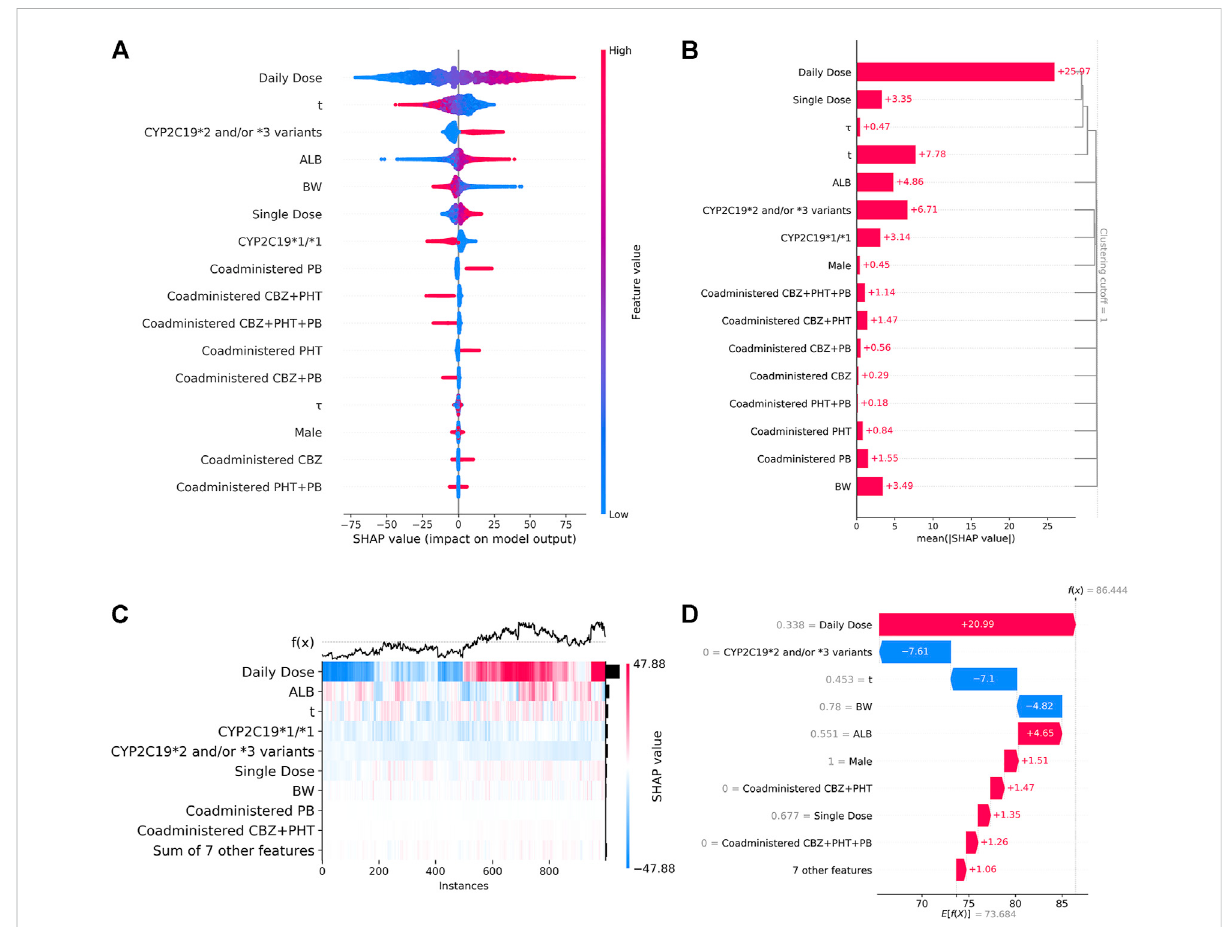
results of the global interpretations of the SHAP summary plot analysis. It indicated the potential difference in the rankings of the contributions of the features at the individual level. The SHAP dependence plots of the top seven key features are displayed in Figure 5, to show how a feature affected the C ss of VPA. Nonlinear associations between features (e.g., t ) and the C ss of VPA were observed. The results showed that higher Daily/ Single Dose and ALB, lower BW, and CYP2C19*2 and/or *3 variants, were related to higher C ss of